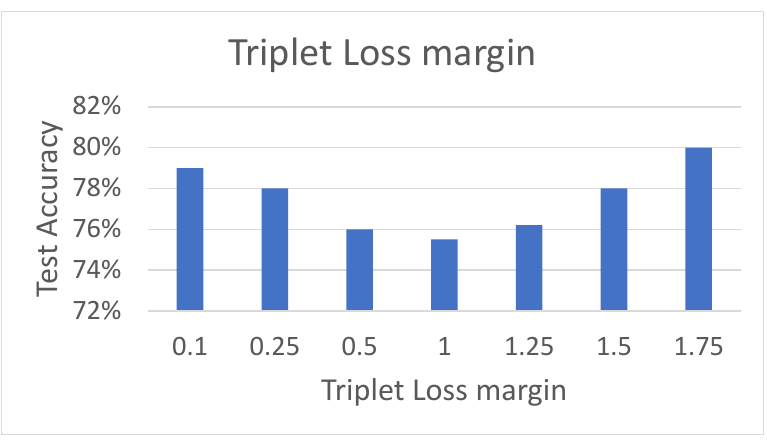
Figure 16. Effect of triplet loss